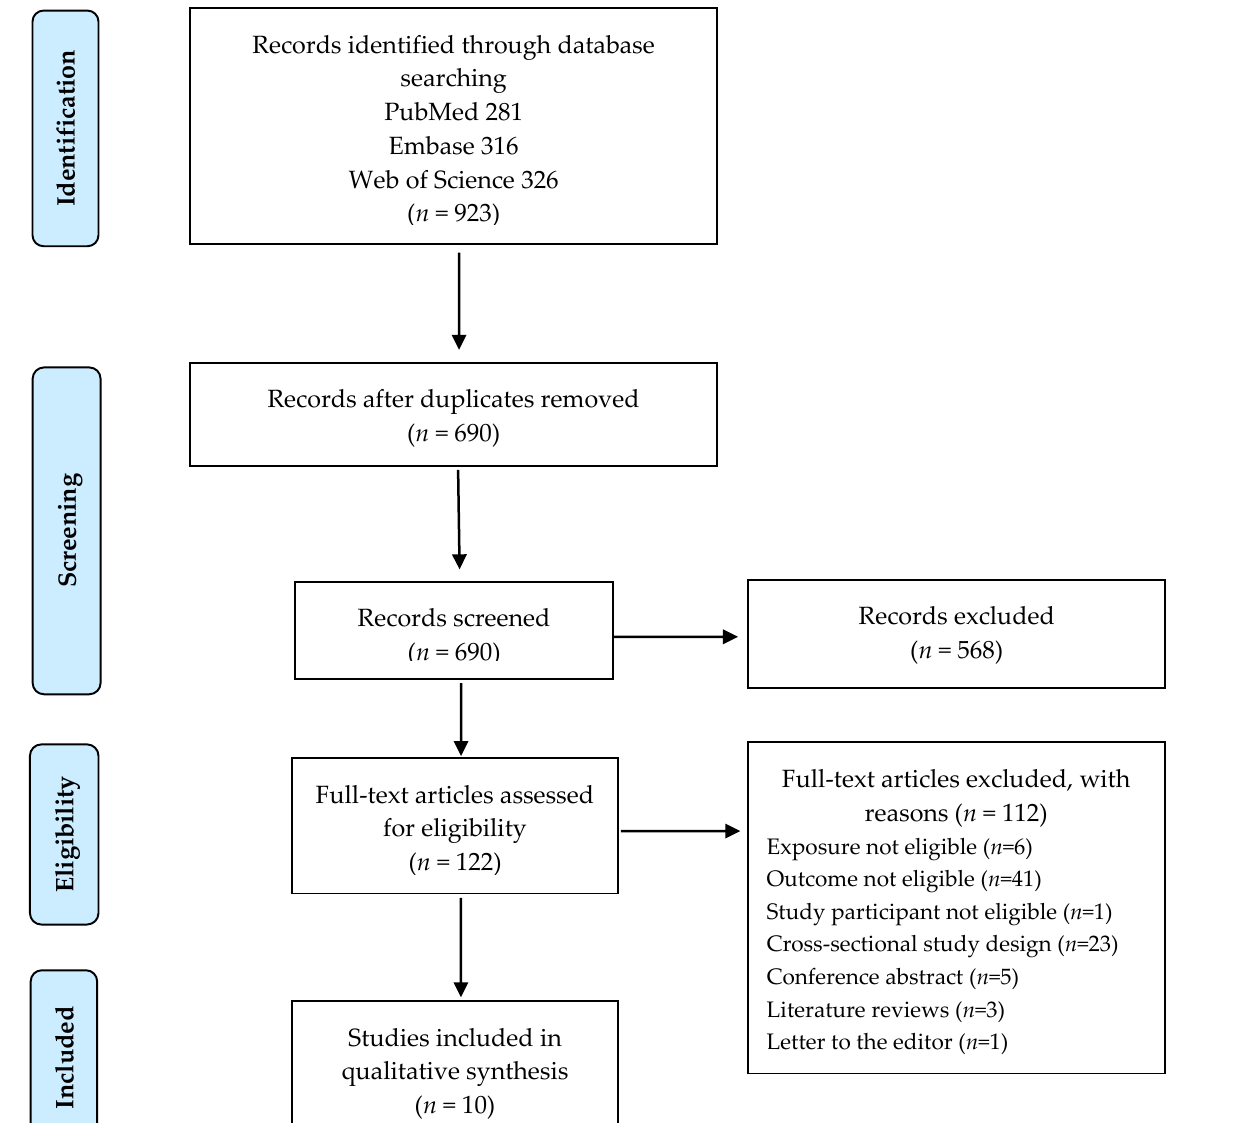
Figure 1. Flow diagram of the literature search.